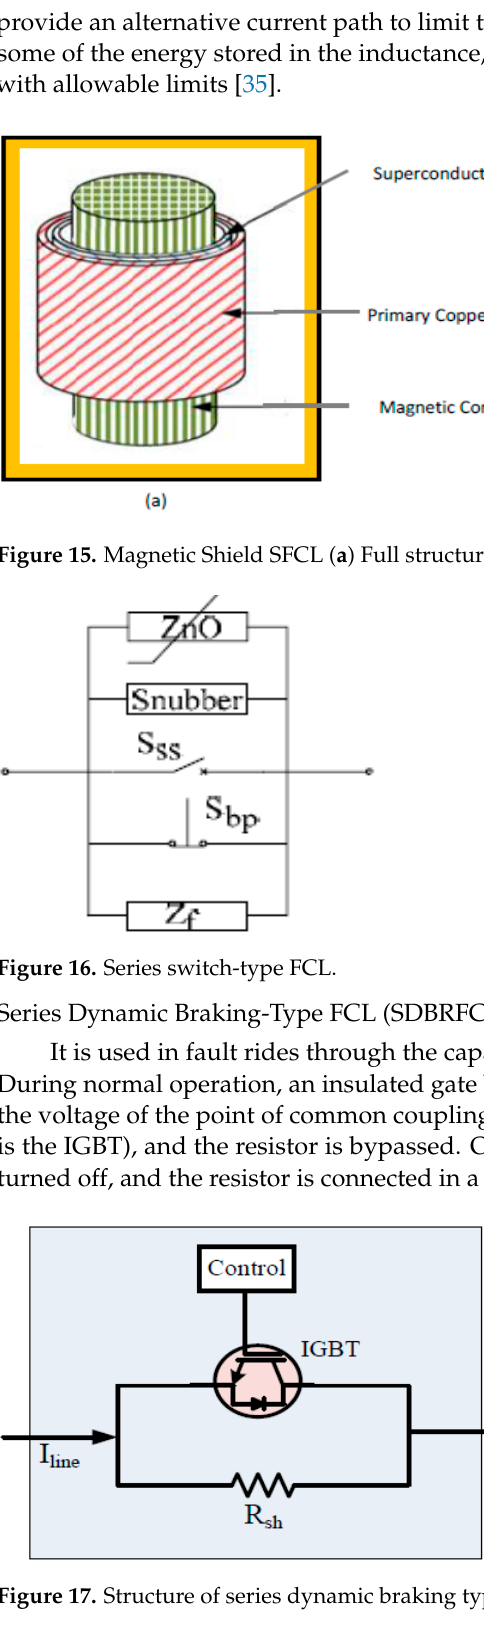
15 of 31 Figure 14. Structure of flux lock type SCFCL.